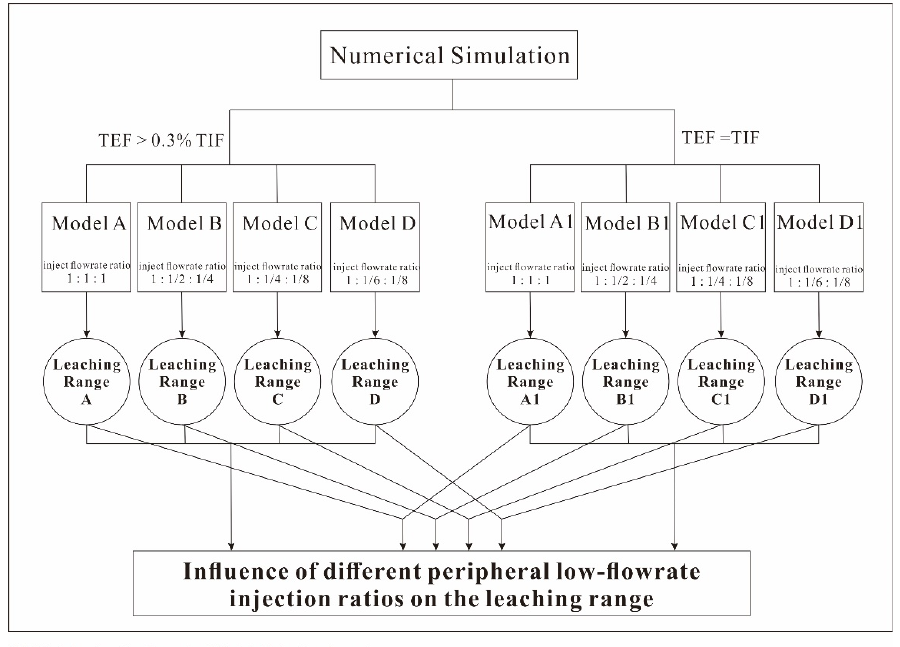
Table 1. Conditions of the comparison test.